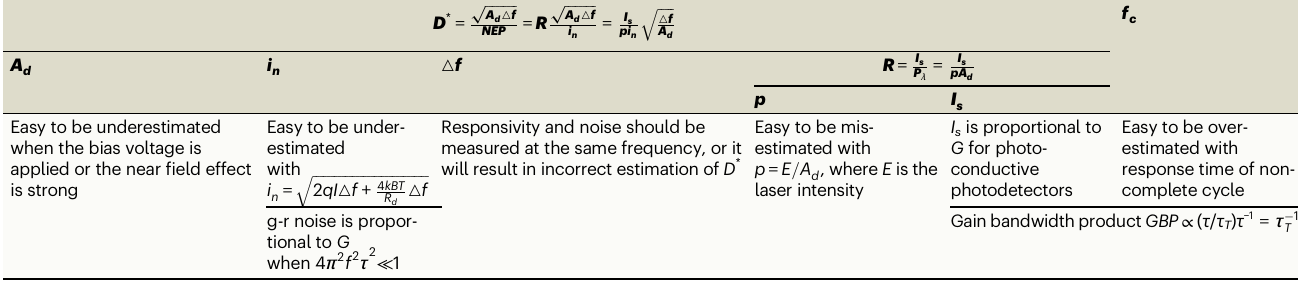
Table 1 | Figures of merit of 2D photodetectors and sources of error in their